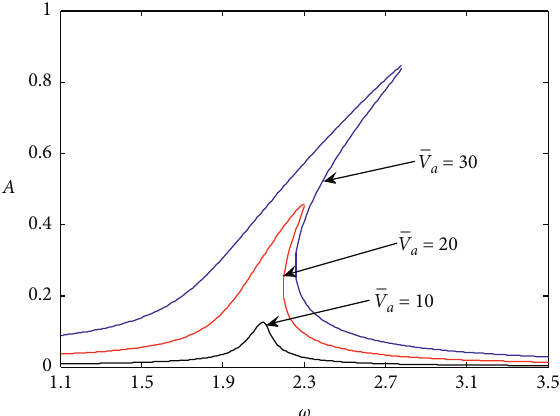
Figure 4: The frequency-response curves of the system for different amplitude of the AC voltage V